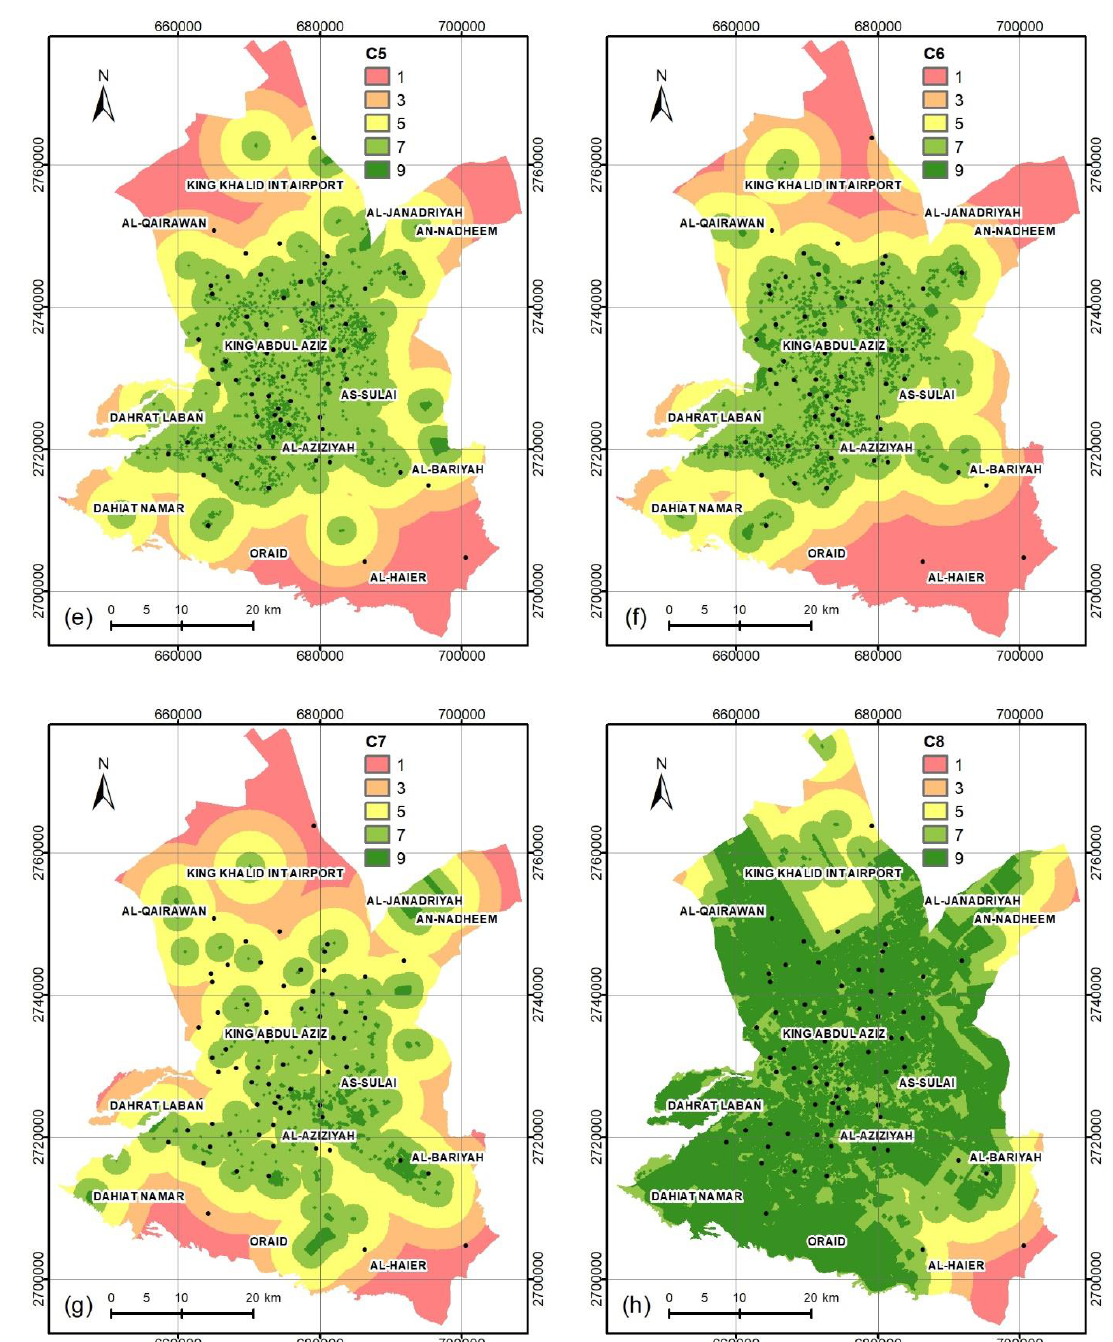
Figure A1. The eight criteria layers: ( a ) distance from the civil defense center; ( b ) accident density; ( c ) population density; ( d ) distance from the road; ( e ) distance from commercial centers; ( f ) distance from educational services; ( g ) distance from industrial areas; ( h ) distance from residential areas.